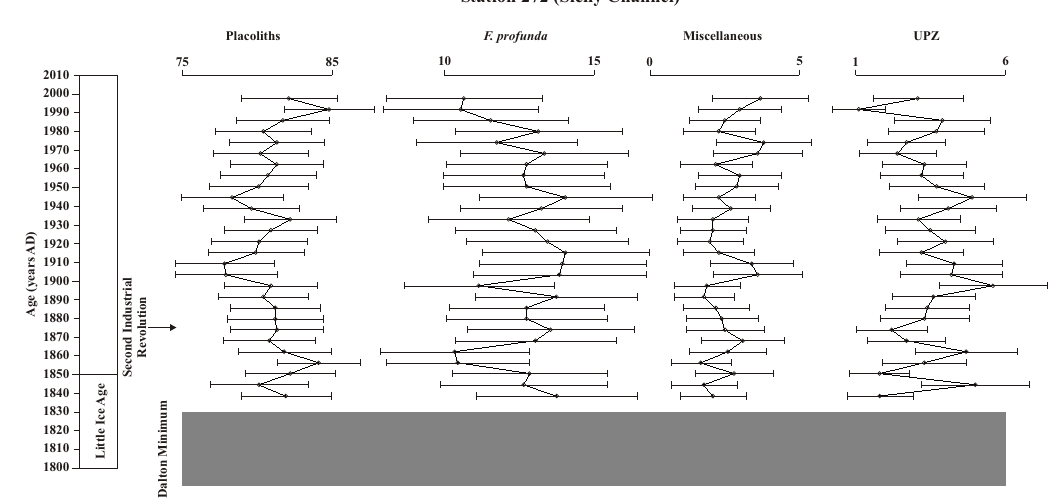
Fig. 3. Distribution patterns of calcareous nannofossil groups (percentage values) at St 272 (Sicily Channel), plotted versus age (years AD). The horizontal bars show the error associated to the countings, for a 95% of confidence level. The top of the Little Ice Age is indicated at 1850 AD, according to (Bradley, 2008; Verschuren and Charman, 2008; Wanner et al., 2008). The Dalton Minimum is also indicated by a gray band, even if no samples come from this horizon.